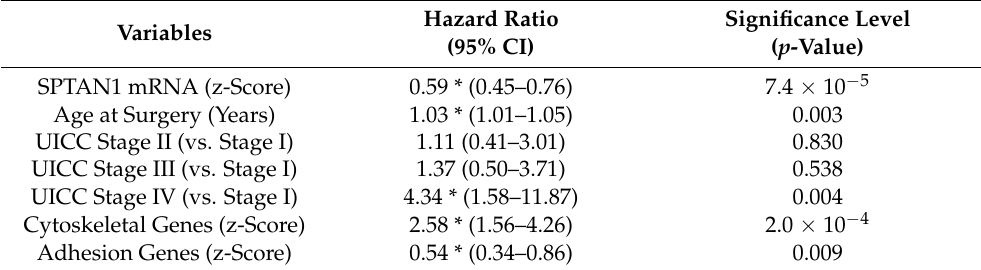
Table 2. Overall survival in the TCGA cohort analysed by multivariable Cox regression.